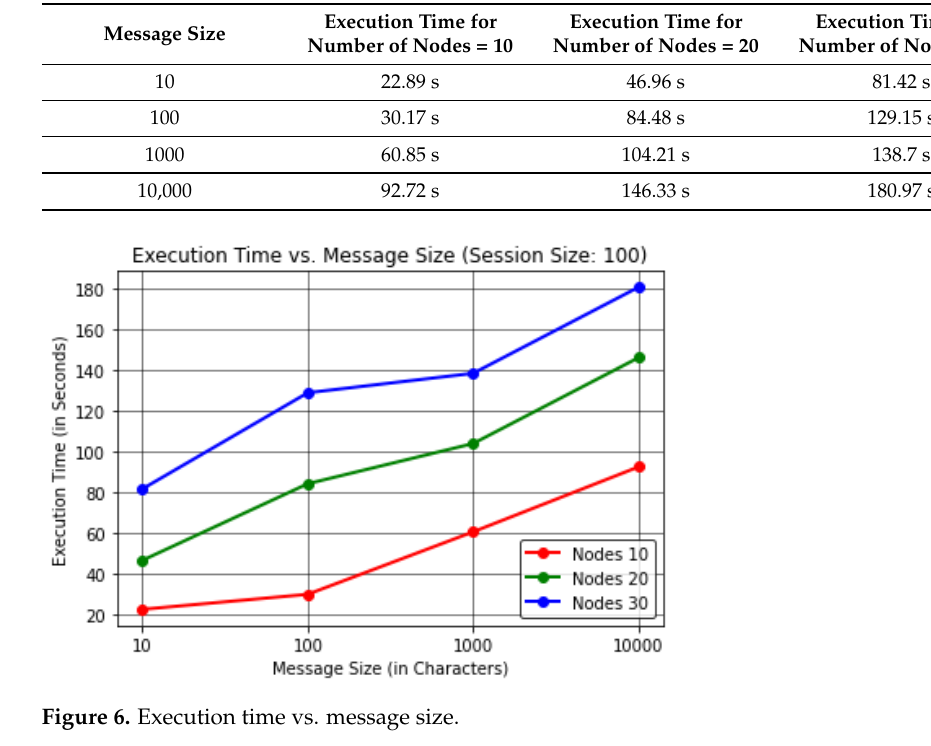
Table 3. Comparison between execution time and message size.